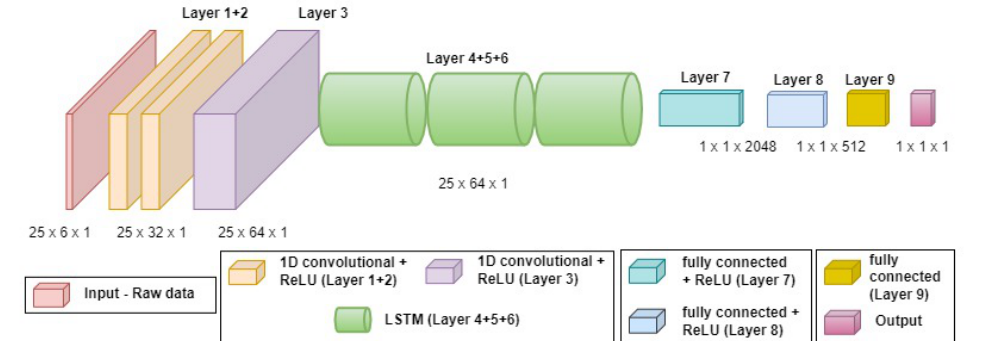
Figure 5. QuadNet2 architecture. A combination of CNN network for feature extraction and LSTM for